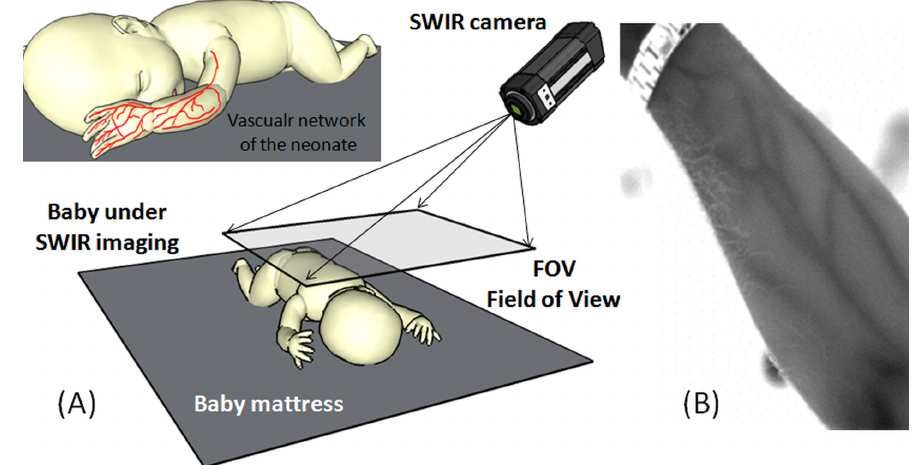
Figure 8. ( A ) imaging setup of the SWIR with field of view (FOV) set to cover the whole body of the neonate; ( B ) SWIR image of an adult hand showing the detailed vasculature of the